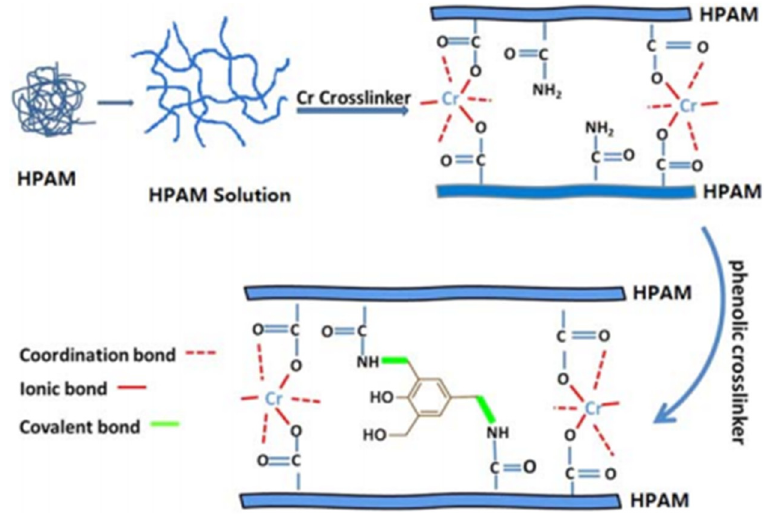
Figure 22. Crosslinking mechanism between chromium lactate and water-soluble phenolic resins. (Reprinted/adapted with permission from Ref. [107], 2015, Zhang et al.).